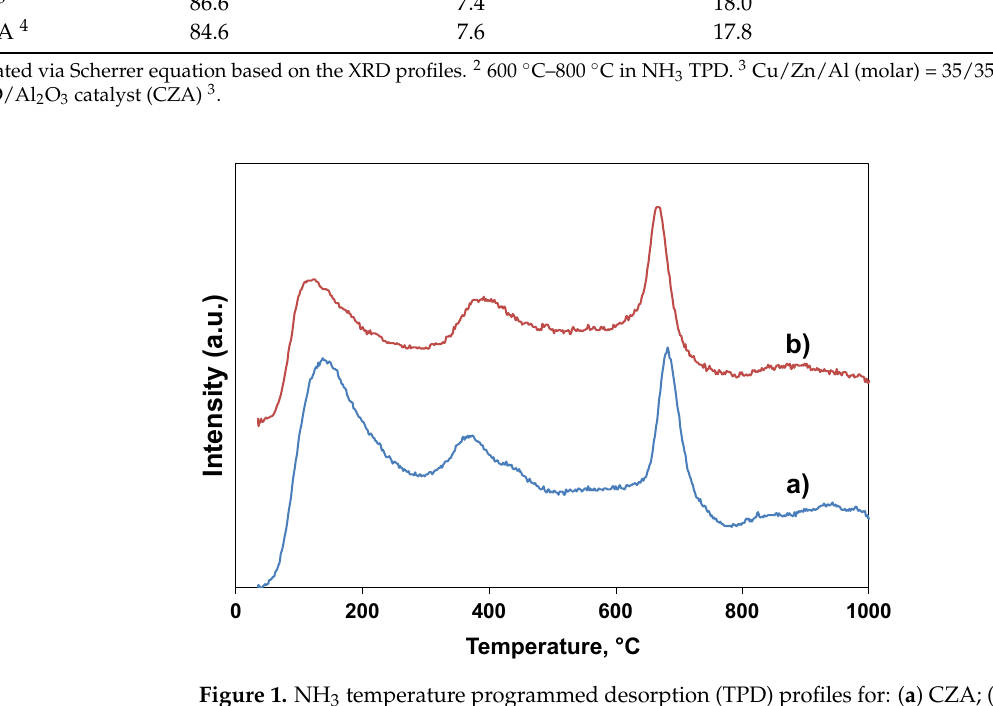
Table 1. Physicochemical properties of the Cu/ZnO/Al 2 O 3 catalyst and its supported Pd catalyst. Catalysts